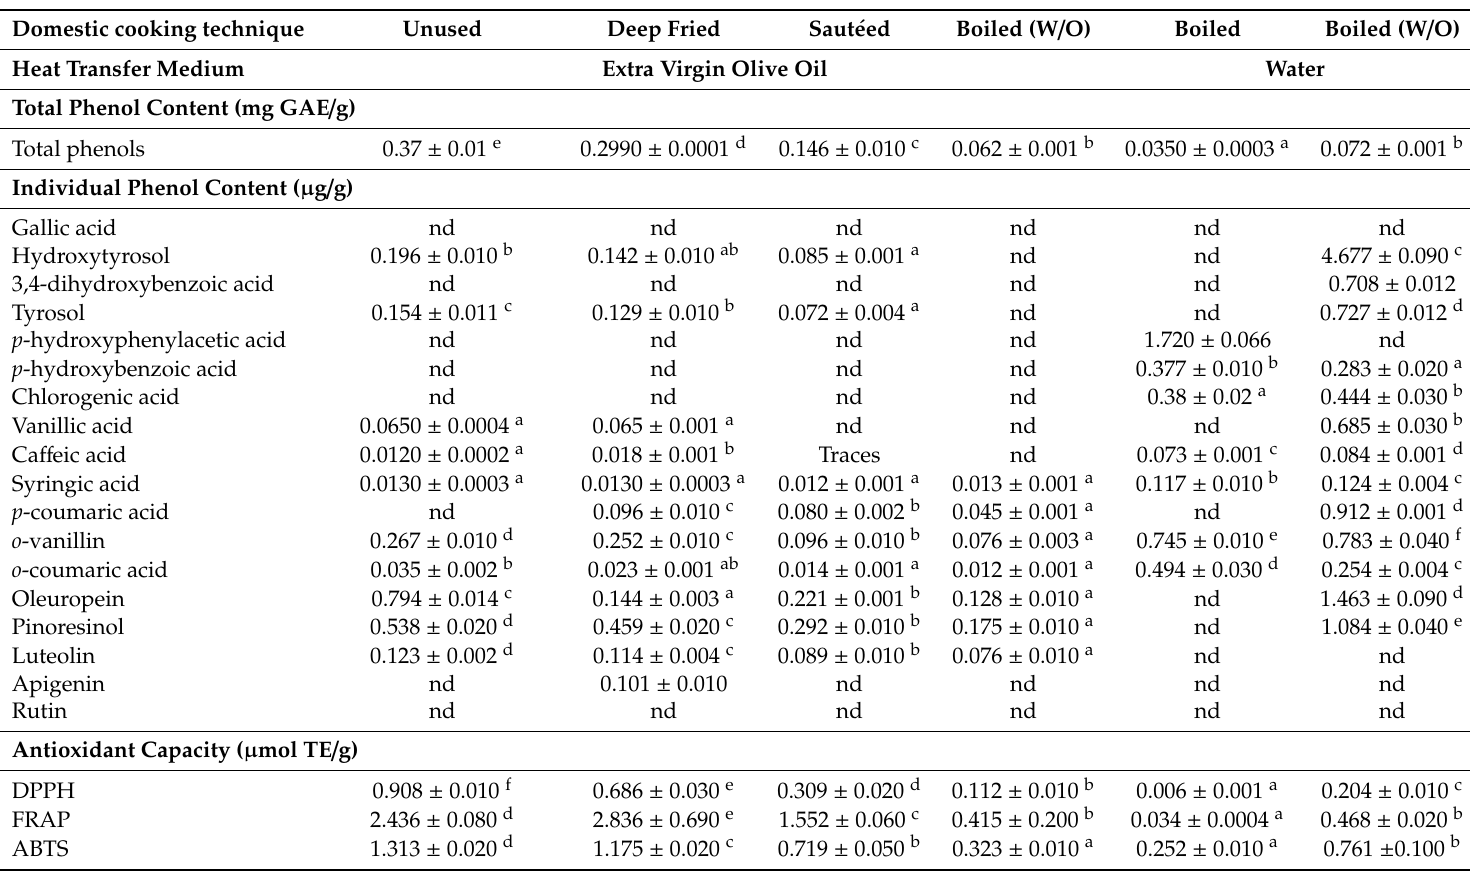
Table 4. Phenolic concentration and antioxidant capacity of EVOO and water used during the cooking of pumpkins according to four